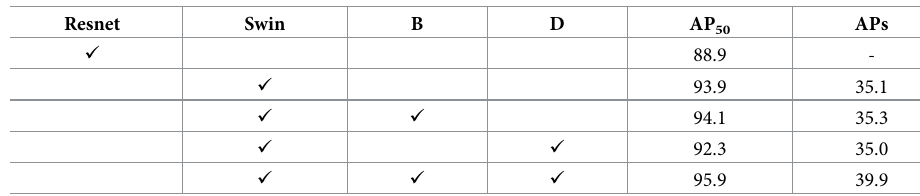
Table 5. Ablation test